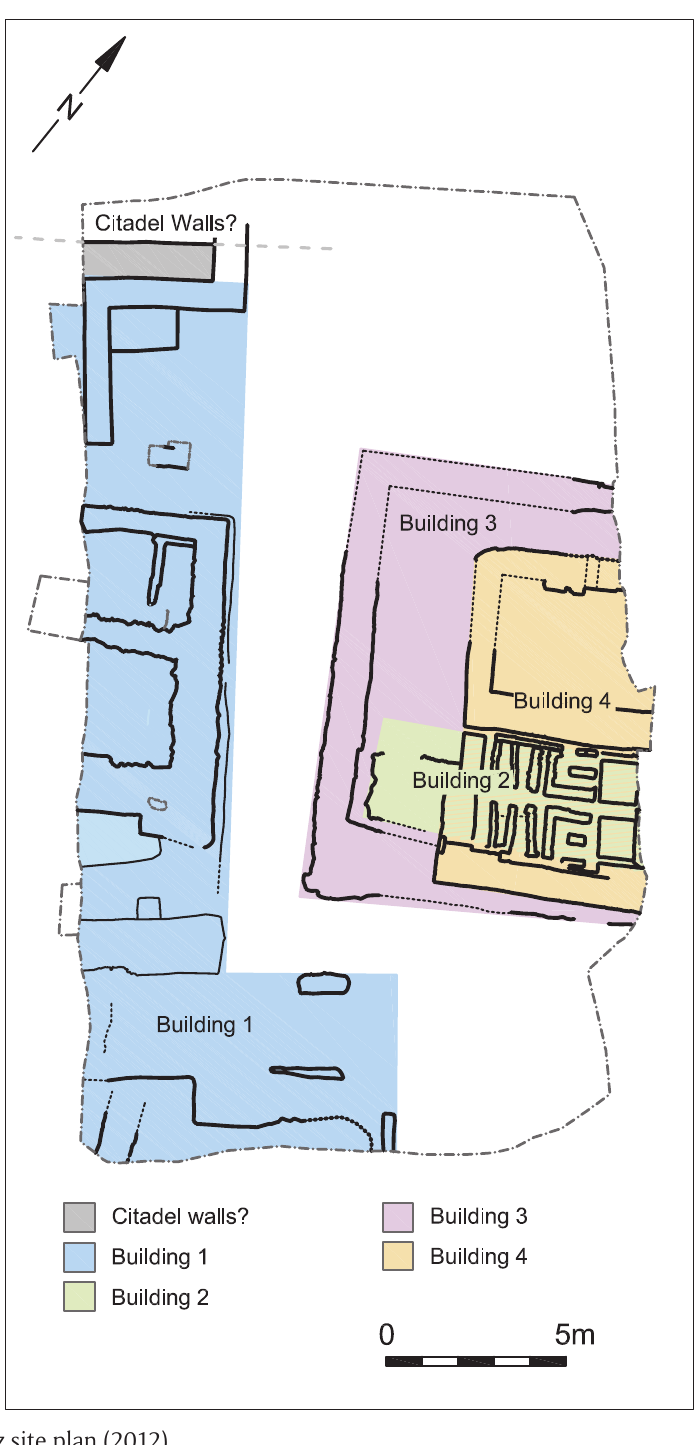
Fig. 5: Taraz site plan